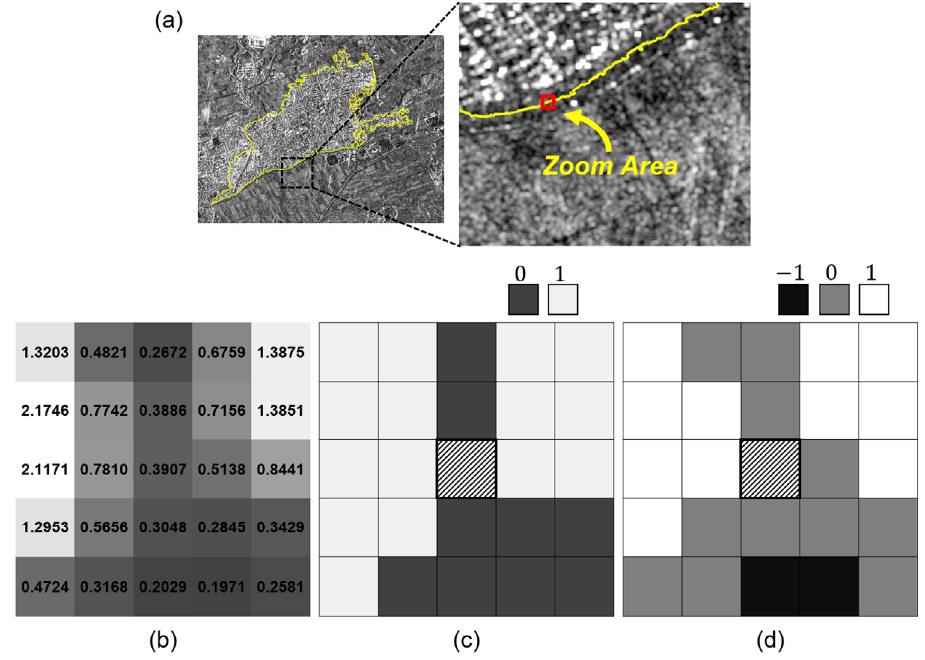
Figure 4. The comparison of binary and ternary codes: ( a ) SAR image showing a 5 × 5 zoom area, ( b ) SAR intensities, ( c ) binary codes, and ( d ) ternary code within the window.